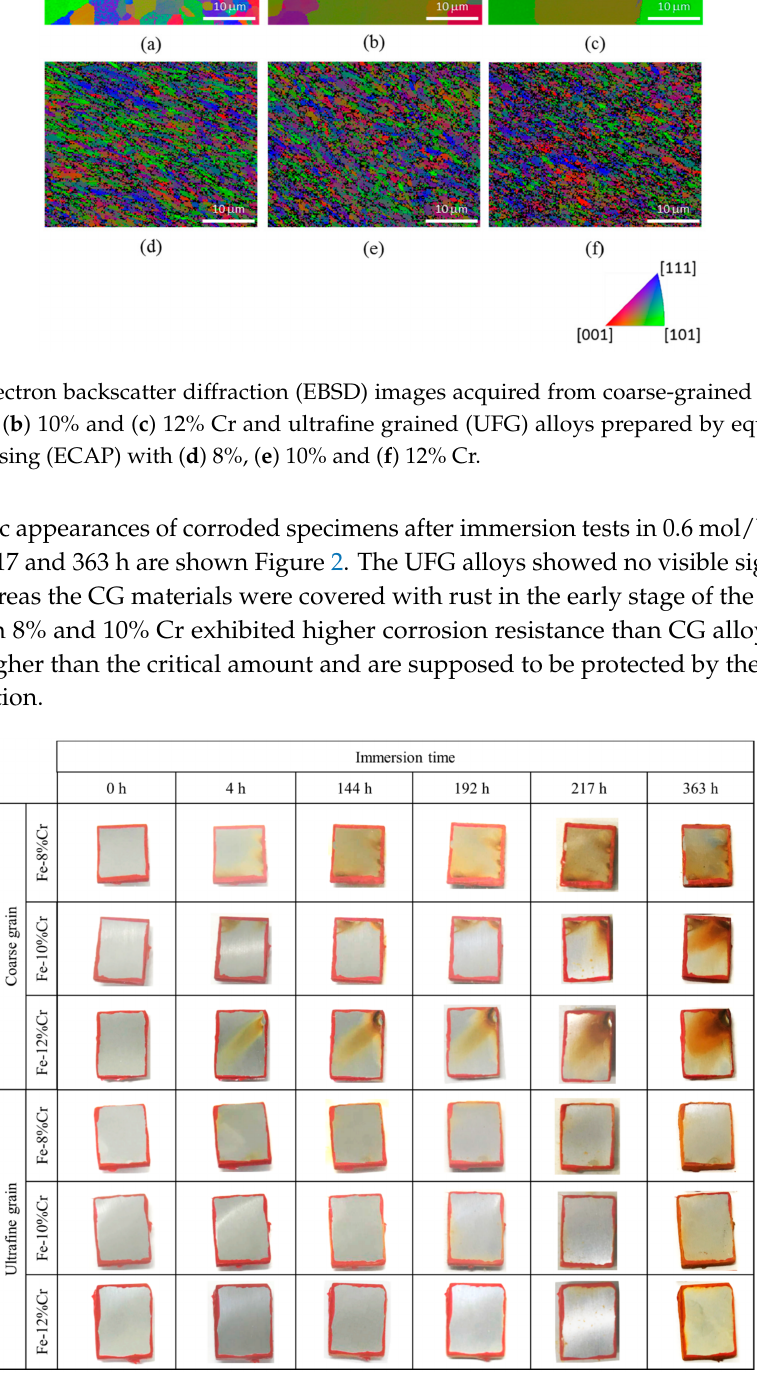
Figure 2. Photographic images showing test specimens after immersion in a 0.6 mol/L NaCl solution for 4, 144, 192, 217 and 363